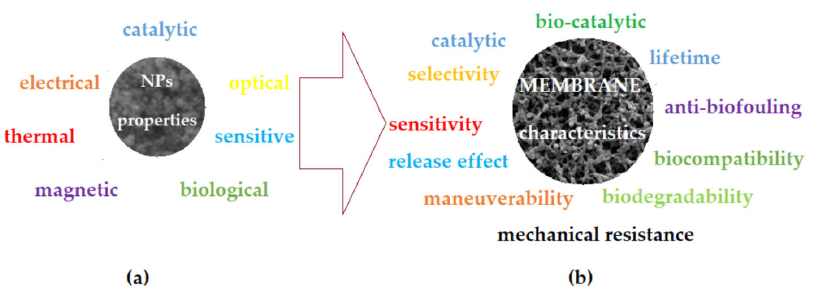
Figure 1. Schematic presentation of the involvement of the properties of nanoparticles ( a ), and the properties needed to achieve the characteristics of membranes ( b ).